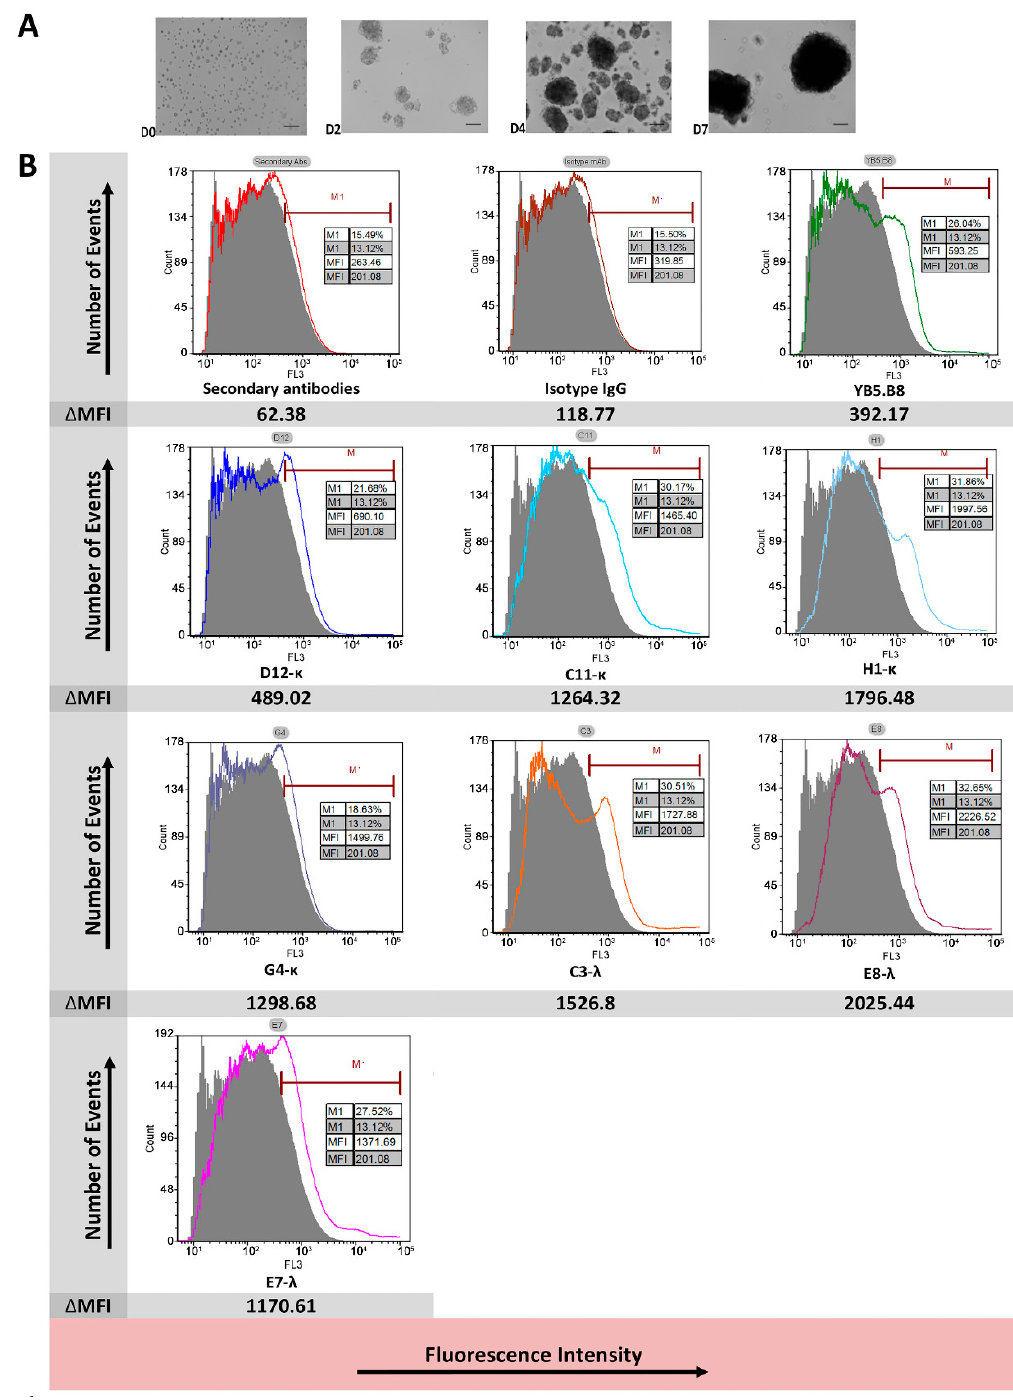
Figure 6. Native canine hemangiosarcoma cells (DD1) expressing CD117 receptors. ( A ) Phase images of canine hemangiosarcoma cells (DD1). Bar = 100 µ m. Cells were cultured in an untreated Petri dish plate under non-adherent spheroid-forming conditions. The propagation of the cells was recorded at day 0 (D0), D2, D4, and D7. ( B ) Testing of phage-derived anti-canine CD117 reformatted antibodies against DD1 cells using flow cytometry. Bound mAbs were detected using Dylight 594 antihuman IgG and antimouse IgG secondary antibodies. Fluorescence was measured using a 561-nm laser and a 630/22-nm filter. The solid lines represent the positive staining of the anti-CD117 mAbs. Control (cells alone) is indicated by the grey shaded region. ∆ MFI (arithmetic mean fluorescence intensity) represents the change in MFI from the control cells to the antibody-treated